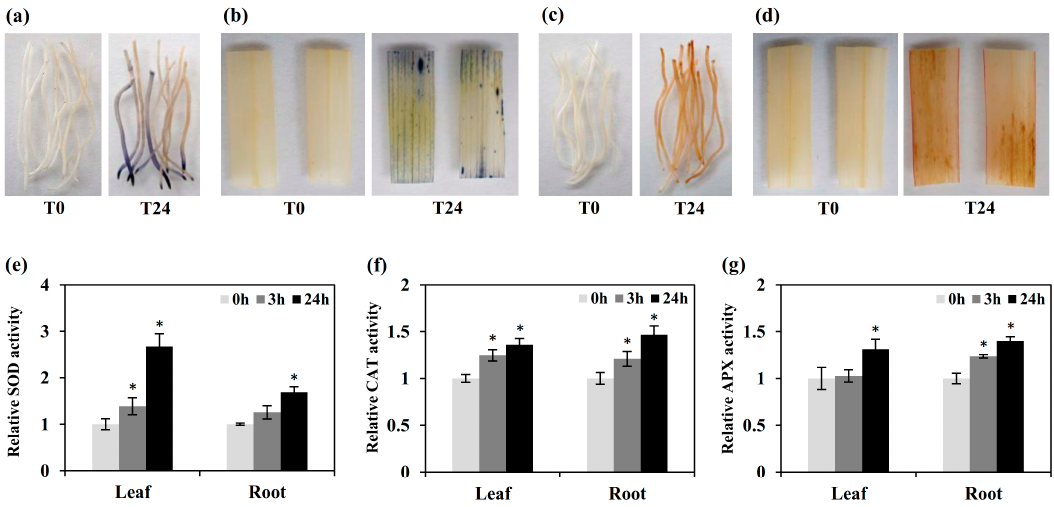
Figure 6. Measurement of ROS levels and anti-oxidative enzymes activity. Detection of O 2 − in leaf ( a ) and root ( b ) of king grass following CdCl 2 exposure at T0 and T24. Detection of H 2 O 2 in leaf ( c ) and root ( d ) of king grass following CdCl 2 exposure at T0 and T24. ( e ) SOD activity. ( f ) CAT activity. ( g ) APX activity. Data are mean ± SD from three replicates. “*” denotes the significant difference between T0 and other time points at p < 0.05 by t -test.